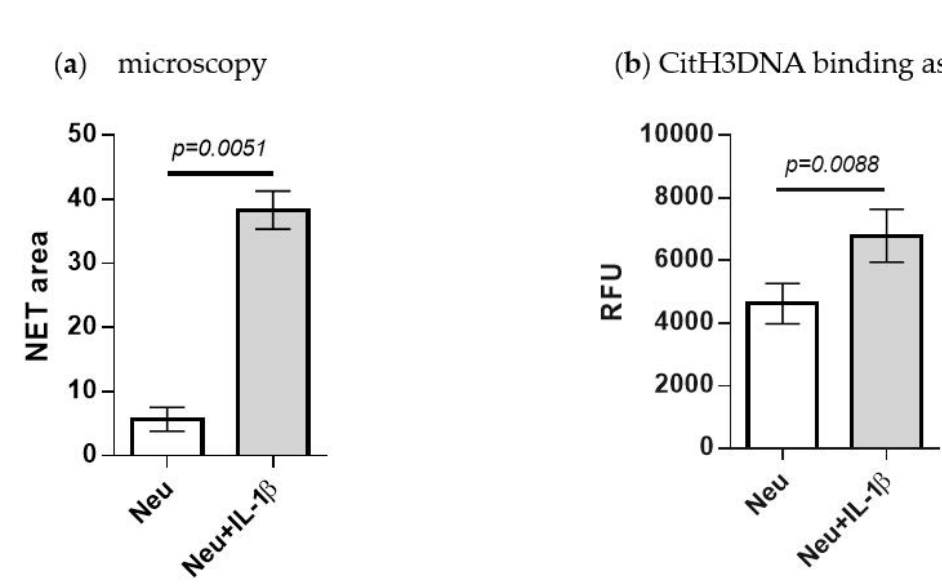
Figure 5. Quantification of citrullinated histone H3 for detection of IL-1 β -induced NETosis. Neutrophils were isolated from the BM of tumor-free mice ( n = 3) and stimulated in vitro with 200 ng / mL of murine IL-1 β for 6 h. ( a ) Formation of NETs was evaluated by microscopy and quantified. ( b ) NET fractions were collected and used in the CitH3DNA binding assay. Mean ± SEM values obtained from neutrophils isolated from 3 individual mice are